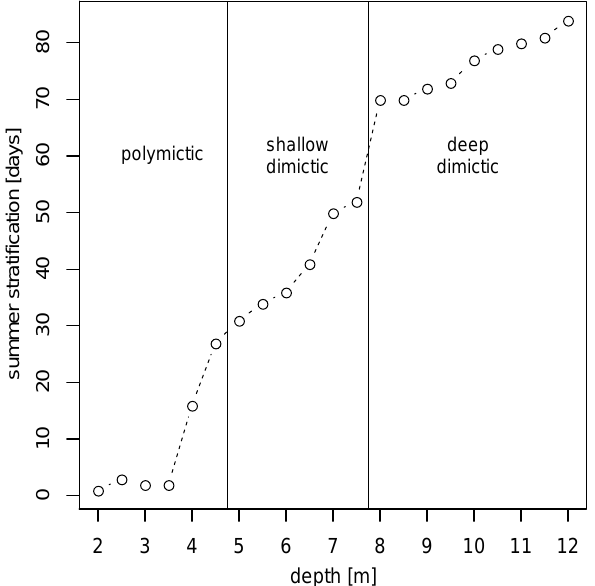
Figure 10. Total number of days with summer stratification in lakes of varying depths modeled with FLake driven by the meteorologi- cal data from the Samoylov observatory station for 2010. Existence of stratification was determined by the criterion ( T s − T b ) >0.5 ◦ C, where T s and T b are the modeled temperatures at lake surface and lake bottom, respectively.